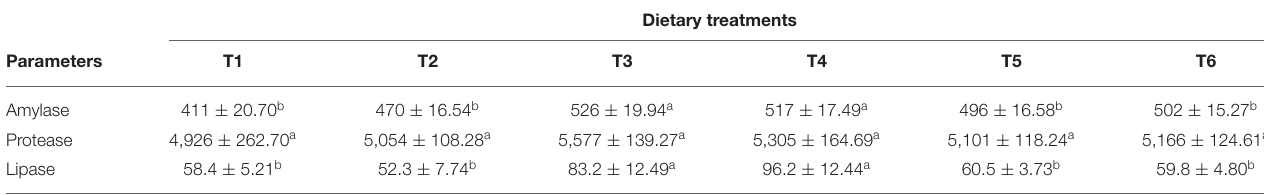
TABLE 6 | Effect of different dietary treatments on the activity of digestive enzymes (U mg − 1 protein) of the pancreas of broiler chickens ( n = 6 chicks per treatment, mean ± SE).